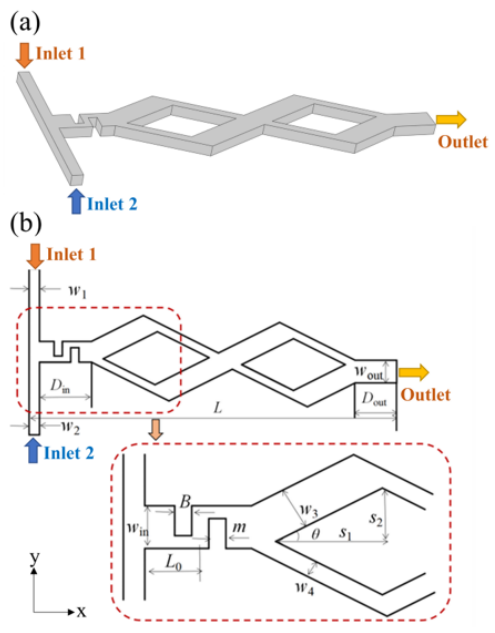
Figure 1. Sketch of the micromixer. ( a ) 3D view; ( b ) Cross section of micromixer. Table 1. Structural parameters of rhombic separation and recombination micromixer.